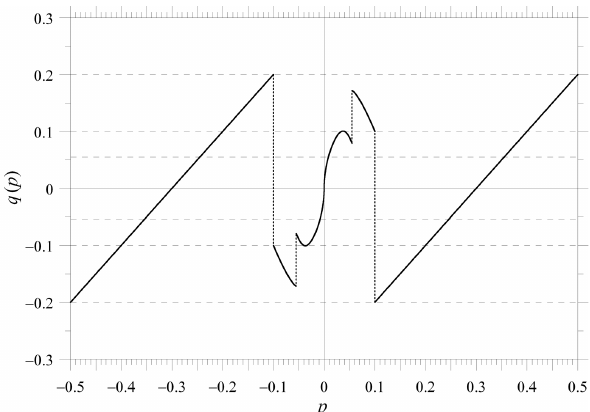
Fig. 4. Function q(p) giving the position of the system in Q after a slip event ( (cid:15) = 0 . 7, α =